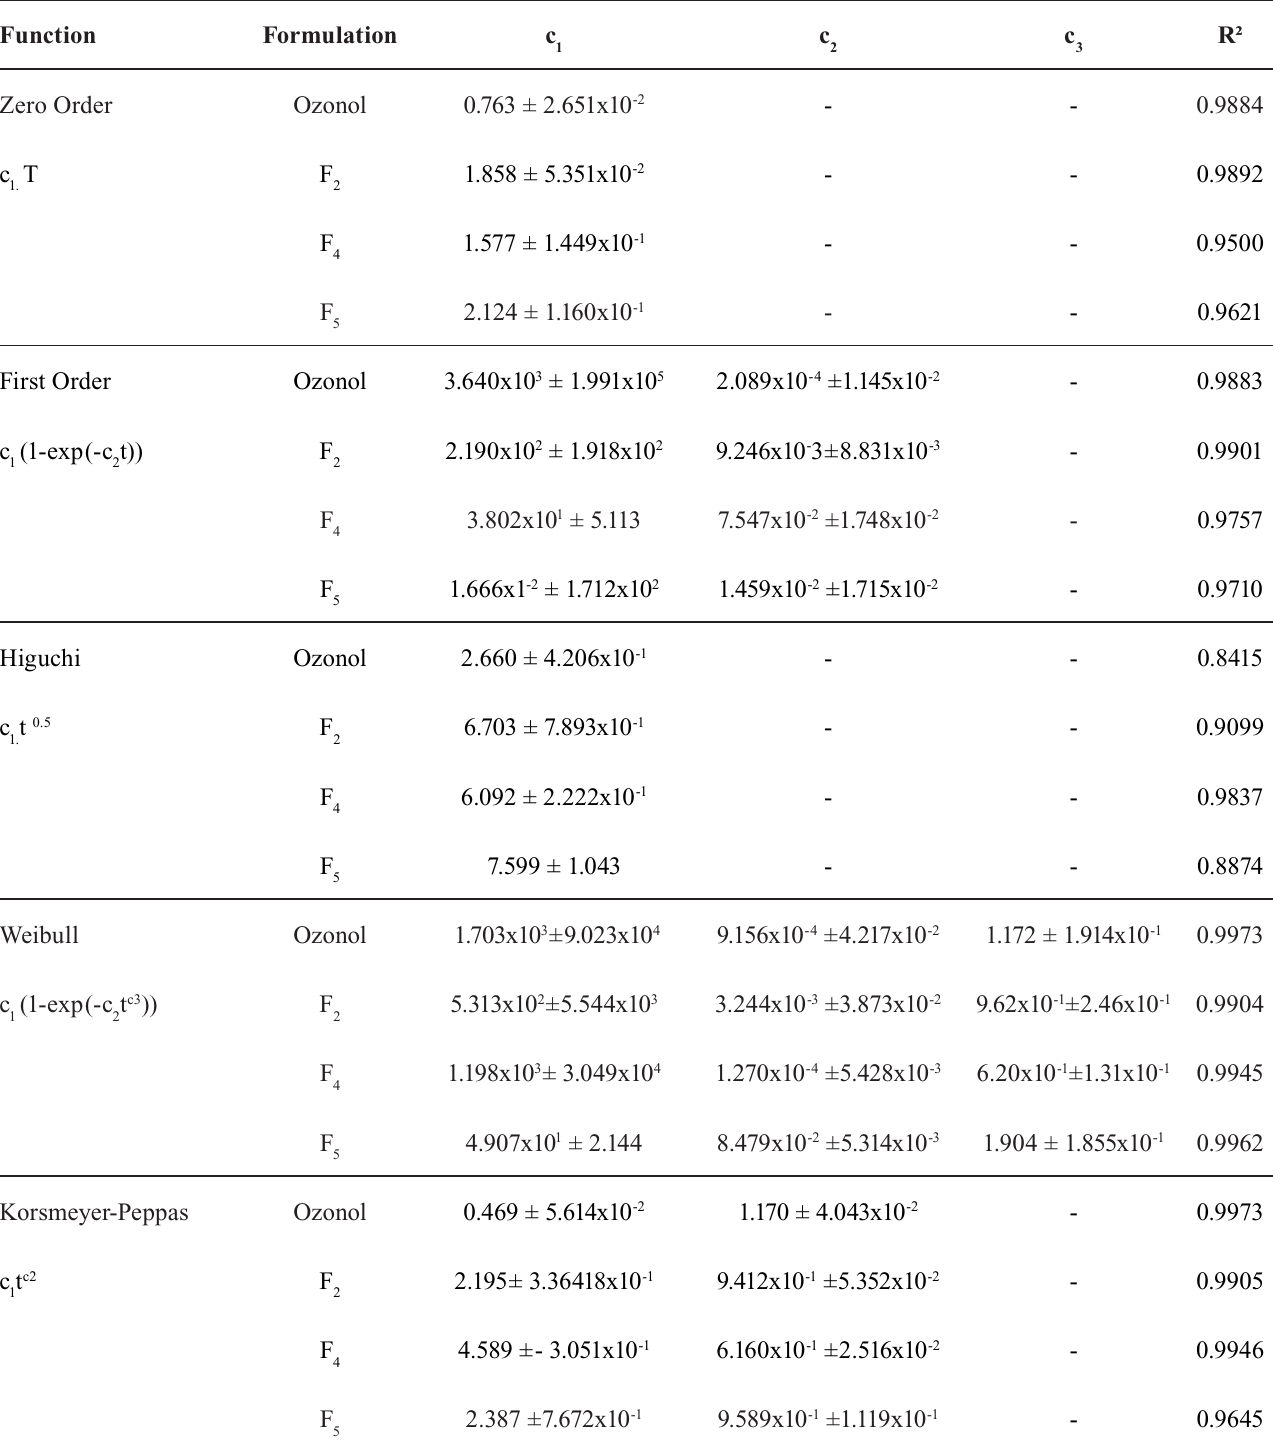
TABLE IV - Regression parameters resulting from the application of the different mathematical models to the